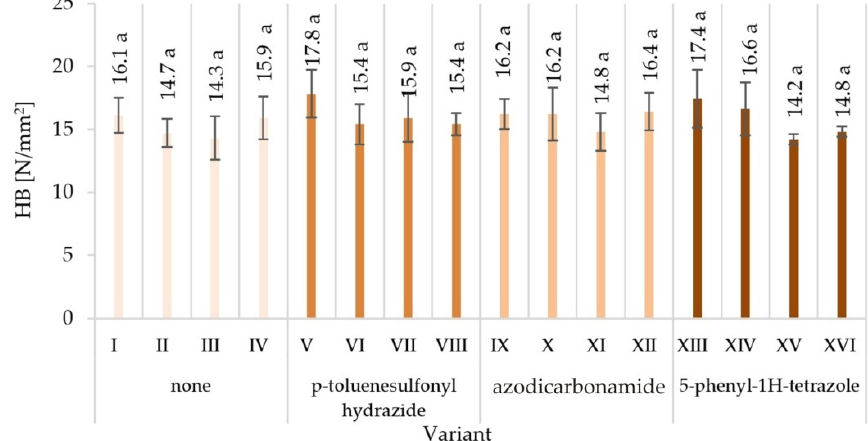
Figure 8. Surface hardness (HB) of particleboards produced (means and standard deviation, a, b, c,